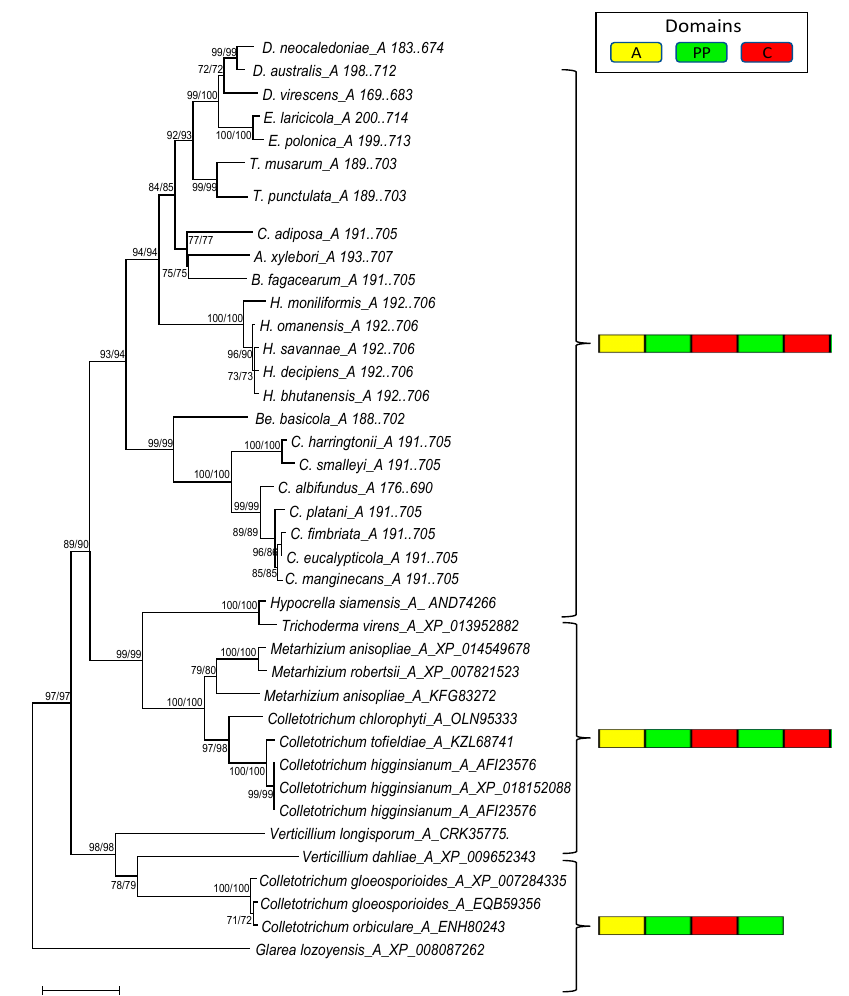
Figure 4. Phylogenetic relationships based on the inferred protein sequences of the A domain from the monomodular NRPS gene examined in this study. The panel to the right indicates the domain structure of the NRPS genes in the respective clusters. The tree was inferred using the neighbor-joining (NJ) method in MEGA v.7 with the LG + I + G + F model. Similar groupings were obtained using maximum likelihood (ML) analysis and the same model parameters. Branch support is indicated at the internodes (>50% bootstrap values based on a 1000 repeats) in the order NJ/ML.